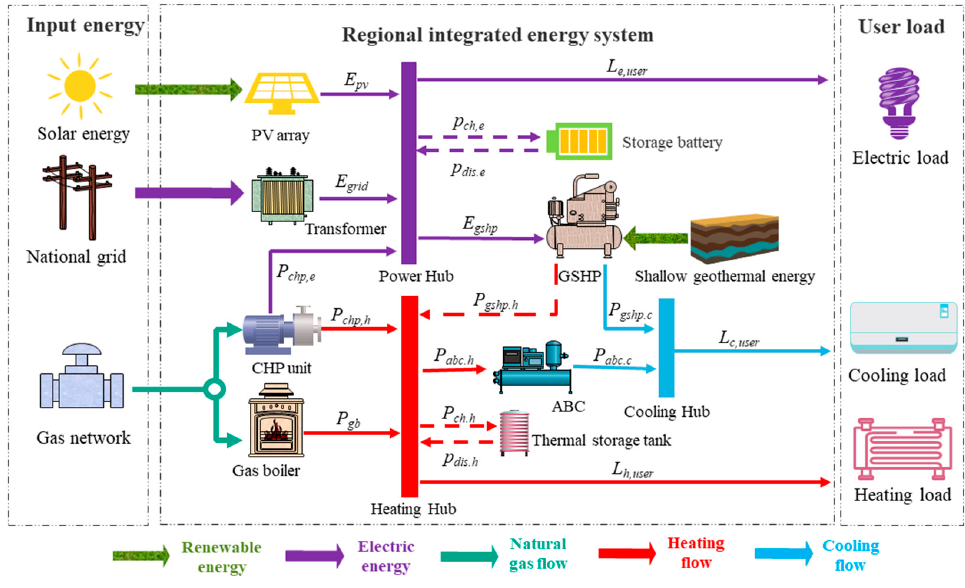
Figure 1. The basic structure of RIESs. Table 2. Three RIESs with different energy storage